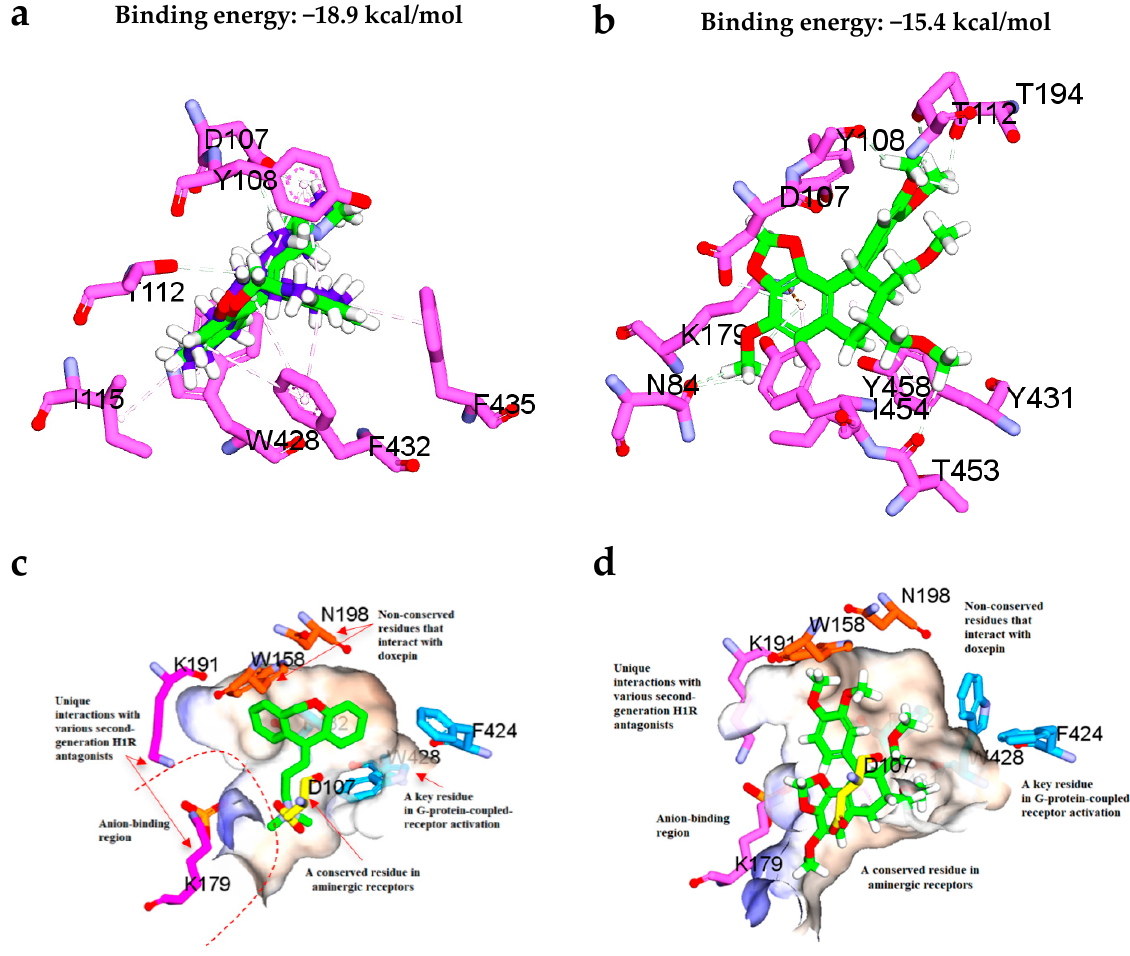
Figure 7. ( a ) Superposition of the docked conformation of doxepin and the original cocrystal doxepin retrieved from the protein crystal structure (PDB ID: 3RZE). The original cocrystal doxepin is colored blue while the docked doxepin is colored green for carbon atoms. ( b ) Binding interactions of the most active compound hypophyllanthin ( 2 ) with the adjacent residues in the H1 receptor binding site. ( c ) Position of the key residues of the H1 receptor binding site in complex with doxepin as retrieved from the protein crystal structure (PDB ID: 3RZE). ( d ) Position of the key residues of the H1 receptor binding site in complex with hypophyllanthin ( 2 ) as predicted from the flexible docking.